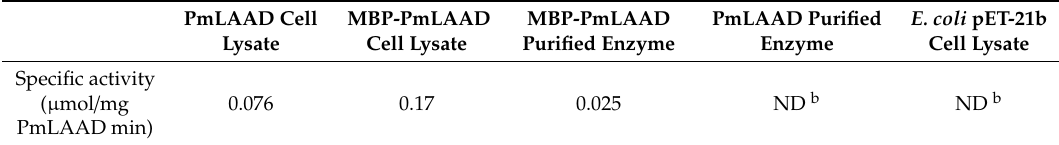
a The reaction time was 30 min. b Not detected.